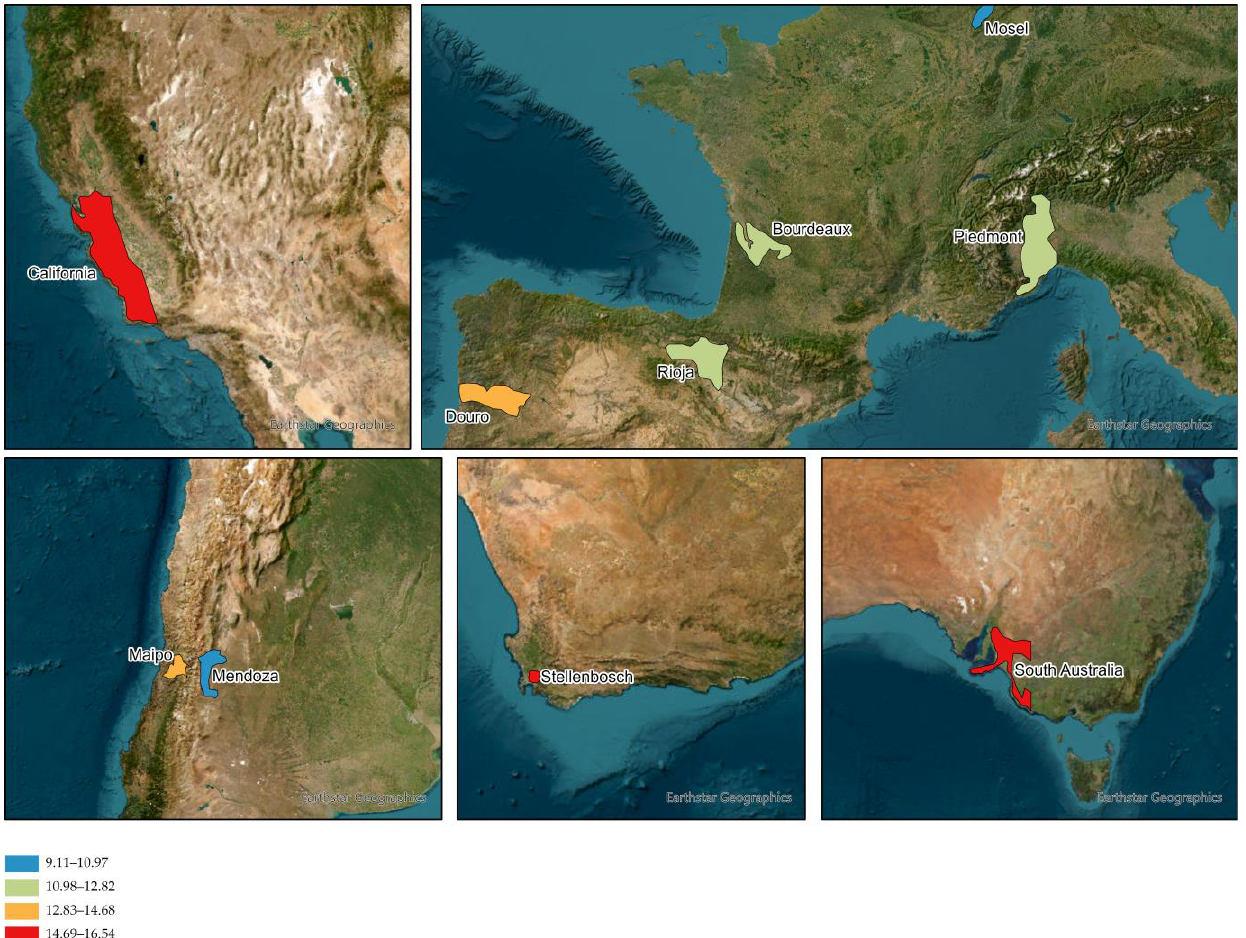
Figure 1. Average annual temperature for selected wine-producing regions for baseline period (1970–2000) in Celsius. Source: Average annual temperature [20], wine-producing regions manually created by the authors, World Imagery by Esri and Earthstar Geographics.